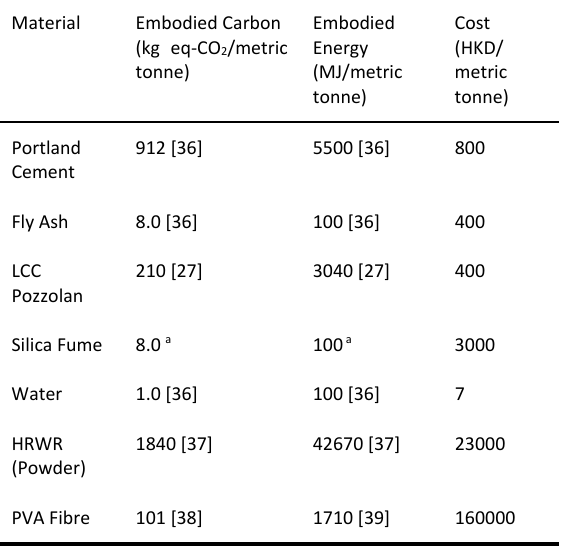
Figure 5 . Tensile behaviour of ECC with ultrahigh ‐ volume fly ash or LCC or both. Table 2. Embodied carbon, embodied energy and cost of